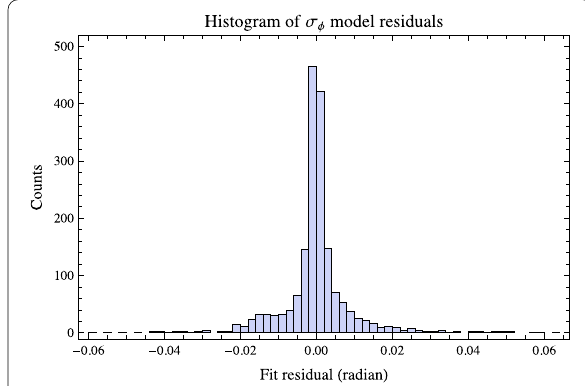
Fig. 23 Fit residuals of σ r , with standard deviation 0.030 pixels (120 K) Fig. 24 Fit residuals of σ φ , with standard deviation 0.0097 radian